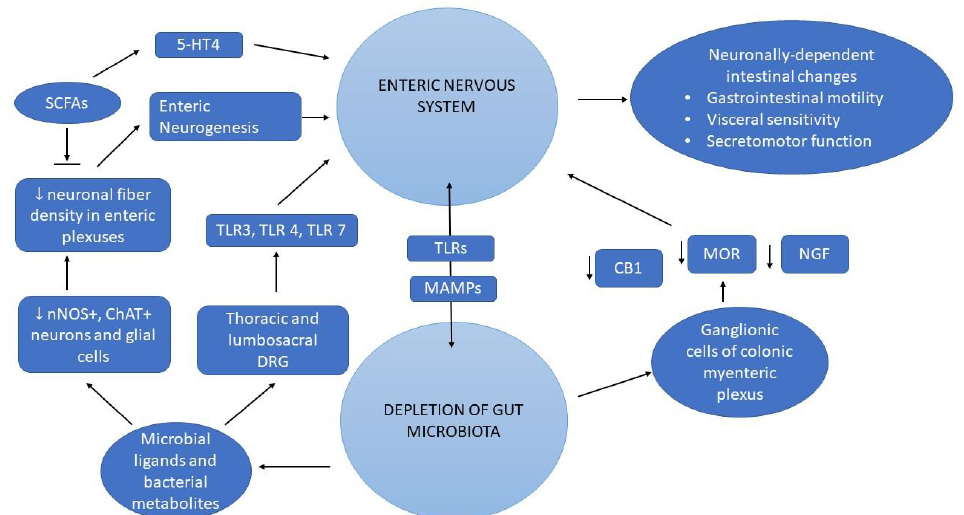
Figure 2. Common pathways shared between gut microbiota and Enteric Nervous System. Abbreviations: CB1, cannabinoid receptor 1; ChAT+, Choline acetyltransferase; DRG, dorsal root ganglia; SCFAs, 5-HT4, 5-Hydroxytryptamine receptor 4; MAMP, microbe-associated molecular pattern; MOR, mu-opioid receptors; NGF, nerve growth factor; nNOS+, Neuronal nitric oxides synthase; SCFAs, Short-chain fatty acids; TLRs, Toll-like receptors;.